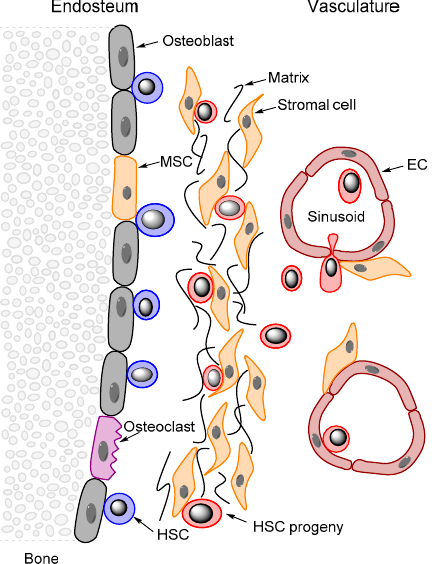
Figure 2. The contribution of MSCs to the microenvironment of bone marrow stem cell niches. Several cell types contribute to the stem cell niches, especially the osteoblasts, MSCs and ECs. The MSCs are localized both close to the sinusoids where they seem to contribute to the regulation of cell trafficking across the vessel wall, and the extravascular space between the vessels and close to the osteoblasts in the endosteum where they also release extracellular matrix molecules. Thus, MSCs are important both for the extravascular microenvironment of the HSCs and for cell trafficking to and from this microenvironment. Monocytes/macrophages and sympathetic nerve fibres are also important for the supportive functions of the stem cell niches; these components are not shown in the